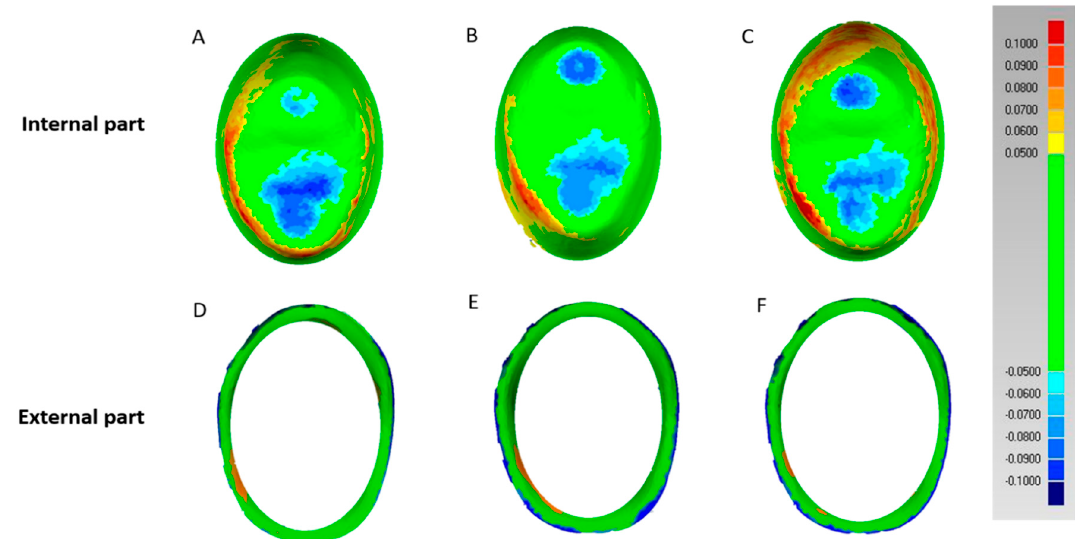
Figure 4. Evaluation of the trueness of crown for the three types of ceramic blocks in the internal and external parts. ( A ) Color difference in the internal part of the AM crown, showing the superimposing of 3D data. ( B ) Color difference in the internal part of the IPS crown, showing the superimposing of 3D data. ( C ) Color difference in the internal part of the CEL crown, showing the superimposing of 3D data. ( D ) Color difference in the external part of the AM crown, showing the superimposing of 3D data. ( E ) Color difference in the external part of the IPS crown, showing the superimposing of 3D data. ( F ) Color difference in the external part of the CEL crown, showing the superimposing of 3D data.